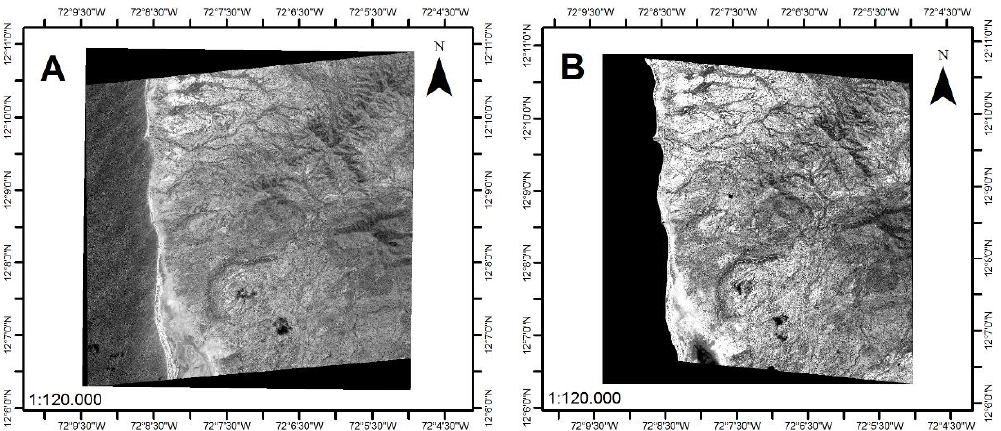
Figure 5. Eros B stereoscopic images ( A MBT1-e2376518, left; B MBT1-e2376519, right 6 February 2013).